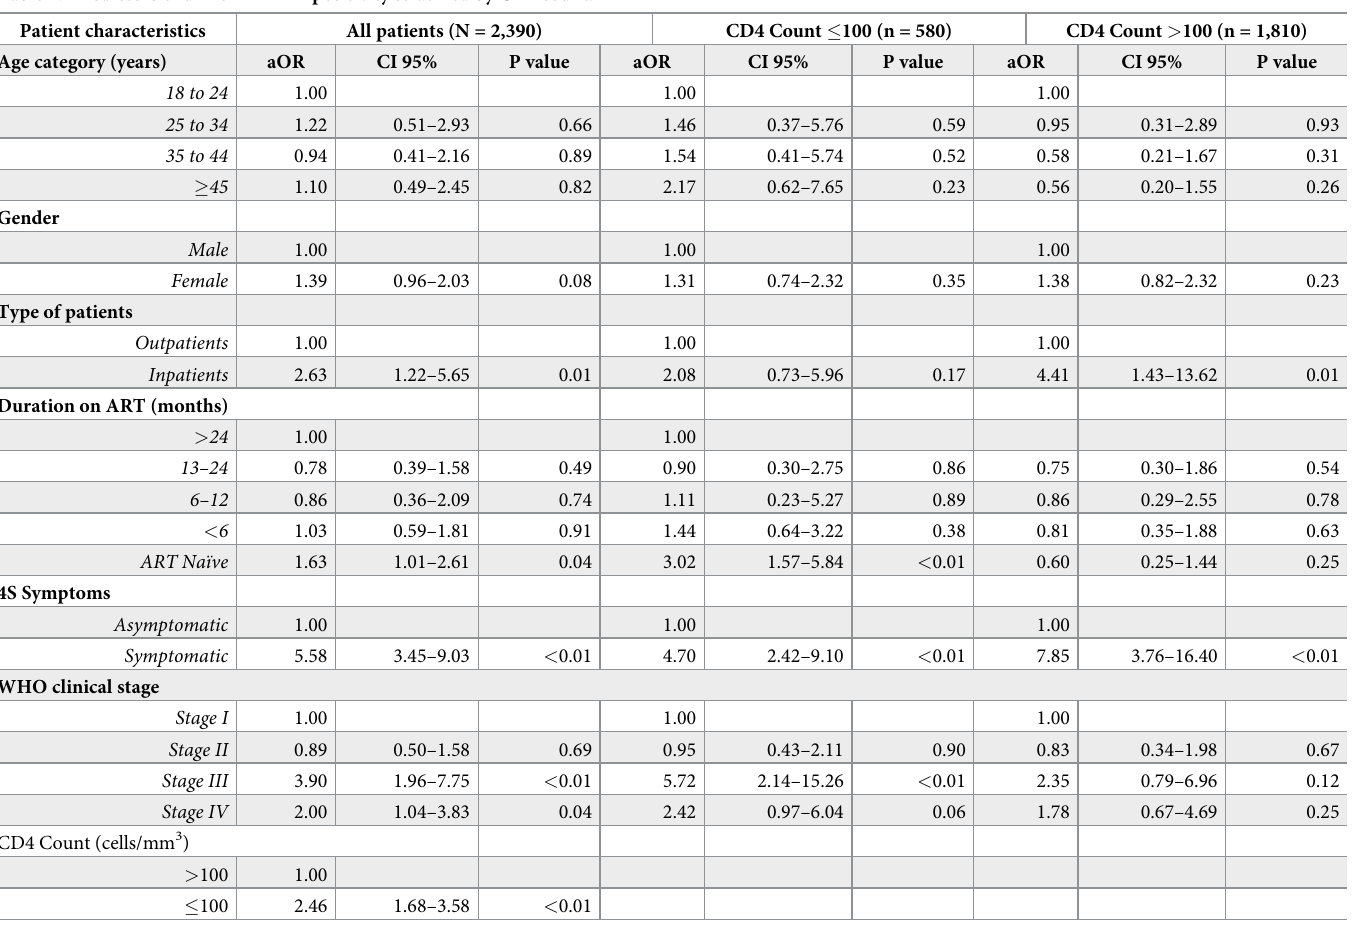
Table 4. Predictors of urine LF- LAM positivity stratified by CD4